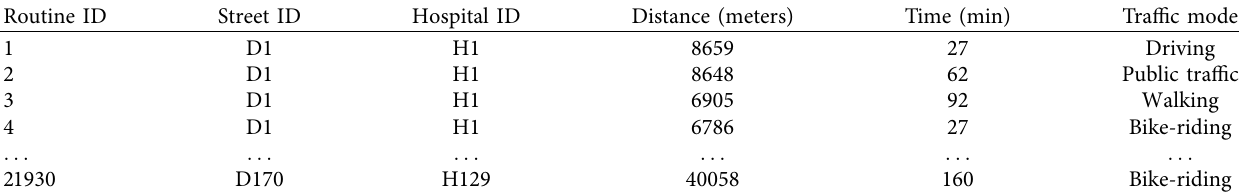
Table 1: Distance and time of routines.